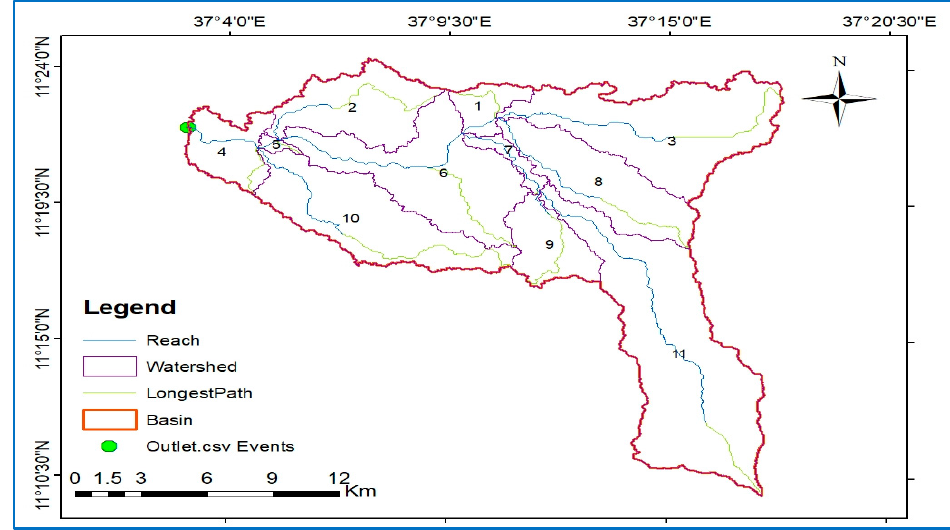
Figure 2. Watershed delineation with sub-basins. By dividing the watershed into regions with the same land use, soil, and slope combi- nations, it is possible to compare the differences in sediment yield and other hydrologic components for various land covers and soils. HRU definitions with several possibilities, which are taken into account for 1% threshold values for land use, 10% for soil, and 10% for slope, are employed in this study while simulating the hydrologic and sediment